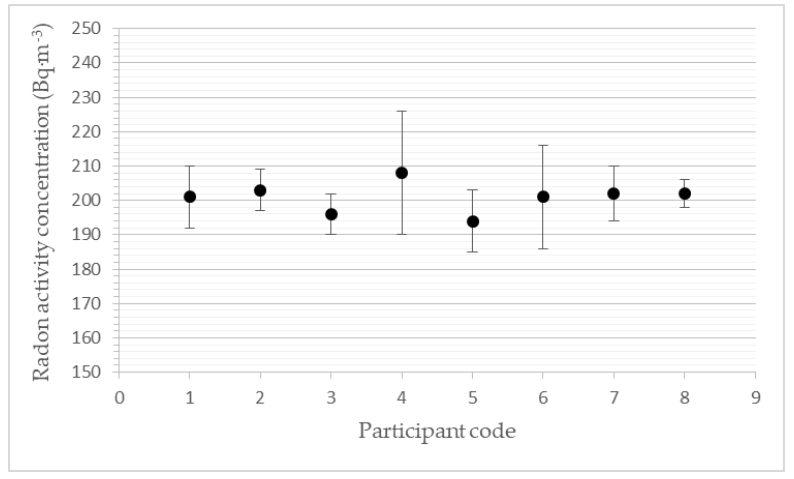
Figure 2. Participants’ devices results for the level of 200 Bq·m −3.